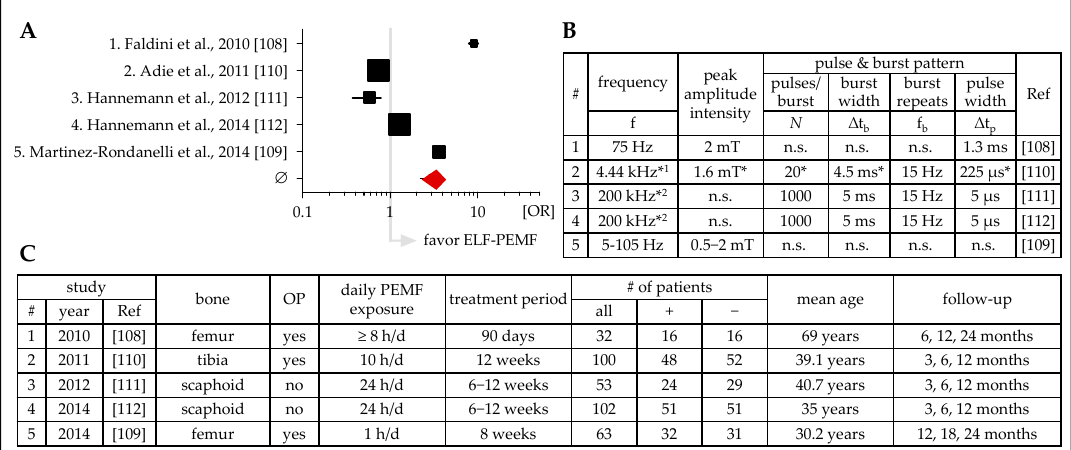
Figure 4. Clinical studies (prospective, placebo-controlled, blinded) investigating the effects of ELF-PEMF treatment on healing of acute fractures. ( A ) Forest plot showing OR ± 95% C.I.—sum was calculated as described by Neyeloff et al . [107], with weighting based on sample size. ( B ) Overview on the ELF-PEMF used in the presented studies. ( C ) Overview on the presented studies including affected bones, number of patients, treatment, and follow up. 1 EBI Bone Healing System, Zimmer Biomet, Warsaw, IN, USA; 2 Bone Growth Stimulator, OSSATEC, Uden, The Netherlands; f: frequency; ∆t (cid:2912) : burst width; f (cid:2912) : burst repeats; ∆t (cid:2926) : pulse width; OP: surgery; + ELF-PEMF treatment; − placebo treatment; n.s.: not specified; * obtained from a secondary source.